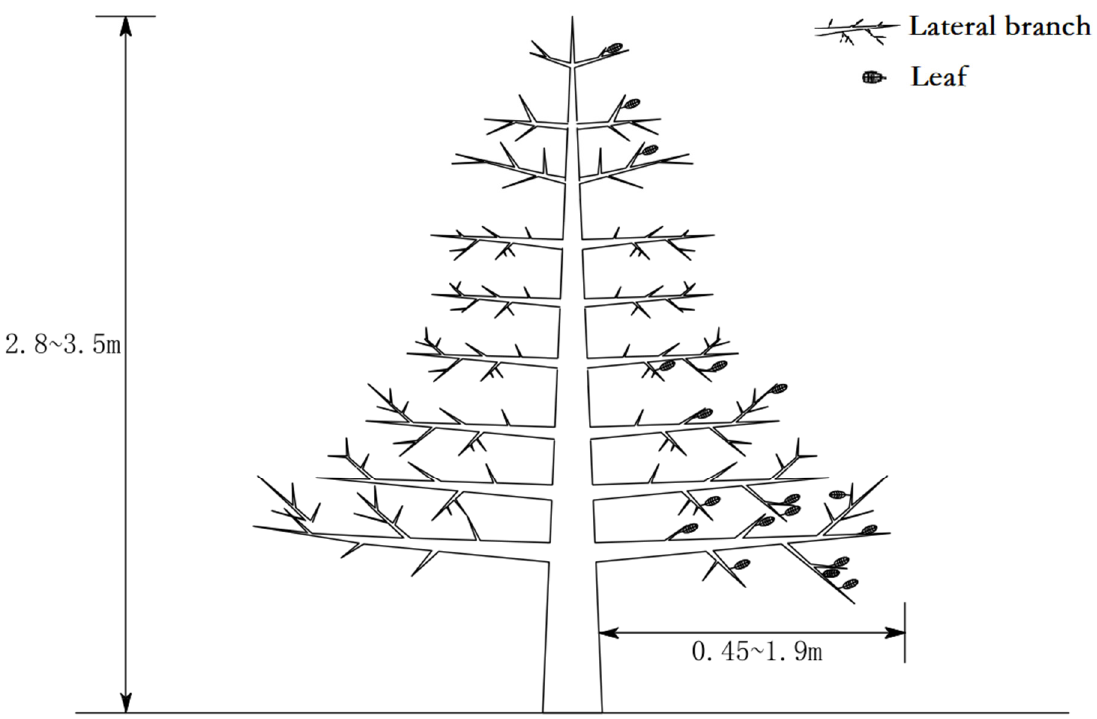
Figure 2. Schematic description of the shape of the experimental pear tree.